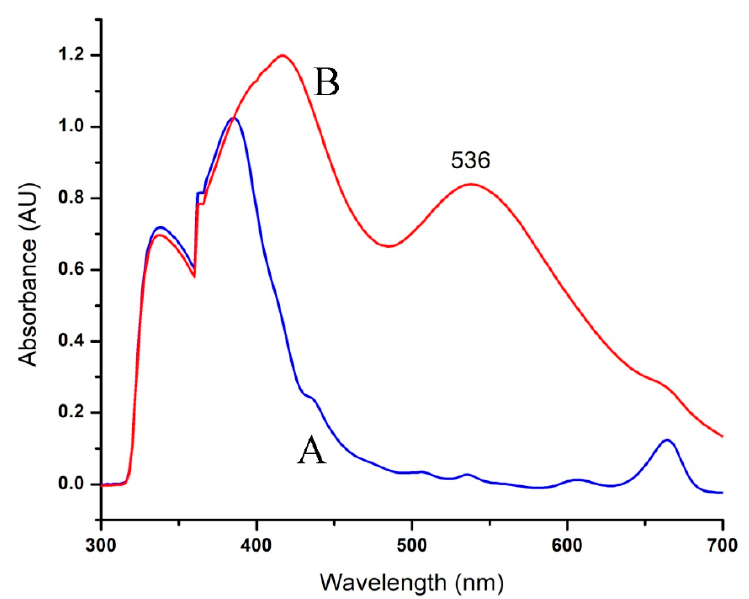
Figure 2. UV-Vis spectra of AuNPs formed through R. communis leaf extract (RcExt): ( A ) denotes the RcExt and ( B ) indicates the RcExt reacted with 1 mM solution of HAuCl 4 ·3H 2 O.